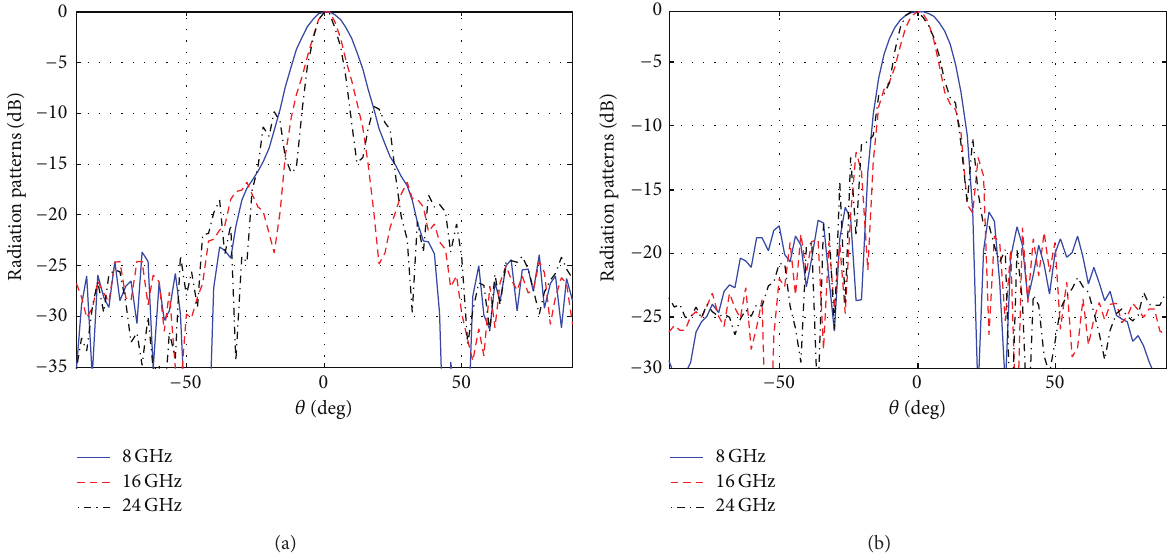
Figure 6: Measured copolarized radiation patterns of LTSA: (a) E -plane; (b) H -plane.